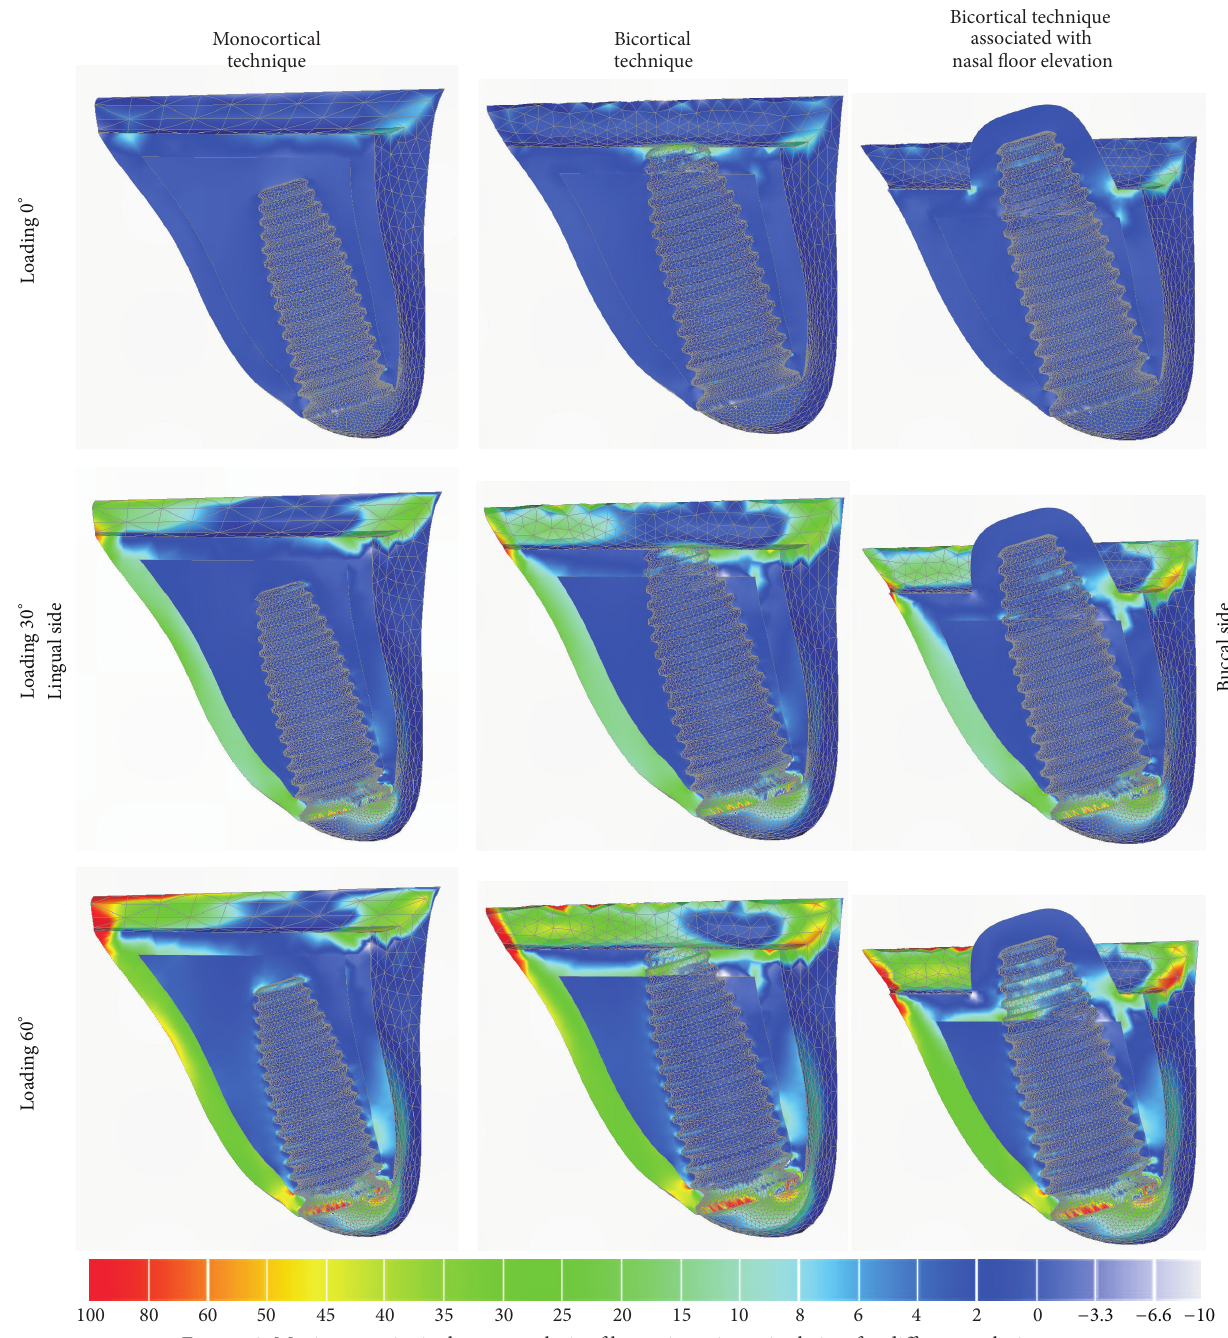
Figure 3: Maximum principal stress analysis of bone tissue in sagittal view for different